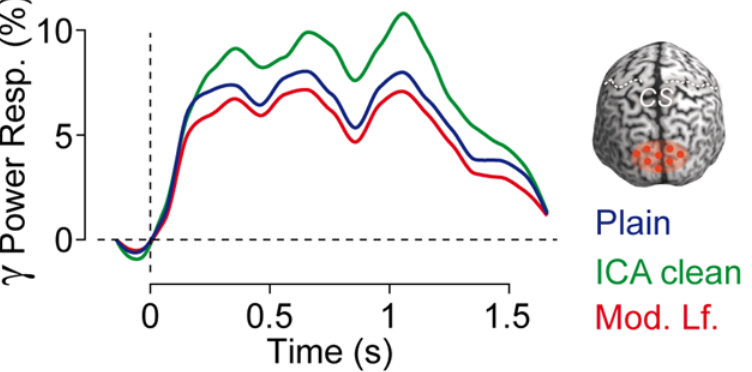
Fig 1. Effect of wrongly correcting the leadfield for source analysis following ICA cleaning. Time courses of source-level gamma band activity (50 – 100 Hz) in response to a moving visual stimulus (onset: t = 0 s; offset: t = 1.52 s) in an occipito-parietal region of interest (see top right). Plain: No ICA-based artifact cleaning. ICA clean: Artifactual ICA components are removed from the sensor level data. Mod. Lf.: As for ICA clean but additionally the leadfield was modified by